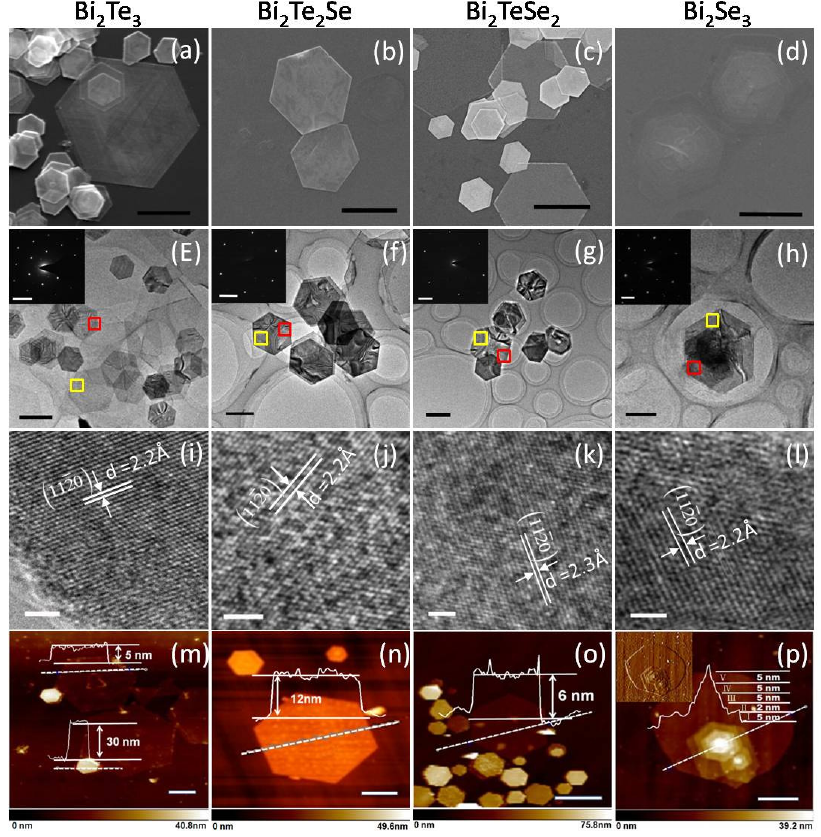
Figure 1. Characterizations of Bi 2 Te 3 , Bi 2 Te 2 Se, Bi 2 TeSe 2 and Bi 2 Se 3 platelets . ( a – d ) Scanning electron microscopy (SEM) and ( e – h ) transmission electron microscopy (TEM) images of these four compounds. The insets of ( e – h ) are selected area electron diffraction (SAED) patterns taken at the red square area in the TEM image. Scale bars in ( a – d ) are 1 μ m. Scale bars in ( e – h ) are 500 nm. ( i – l ) High-resolution transmission electron microscopy (HRTEM) images taken at the yellow square area in TEM images ( e – h ). Scale bars: 2 nm. ( m – p ) Typical atomic force microscope (AFM) images and height profiles of Bi 2 Te 3 , Bi 2 Te 2 Se, Bi 2 TeSe 2 and Bi 2 Se 3 platelets . The height profiles floating on the images were taken at the dashed lines. The inset in ( p ) shows the phase image. Scale bars: 1 μ